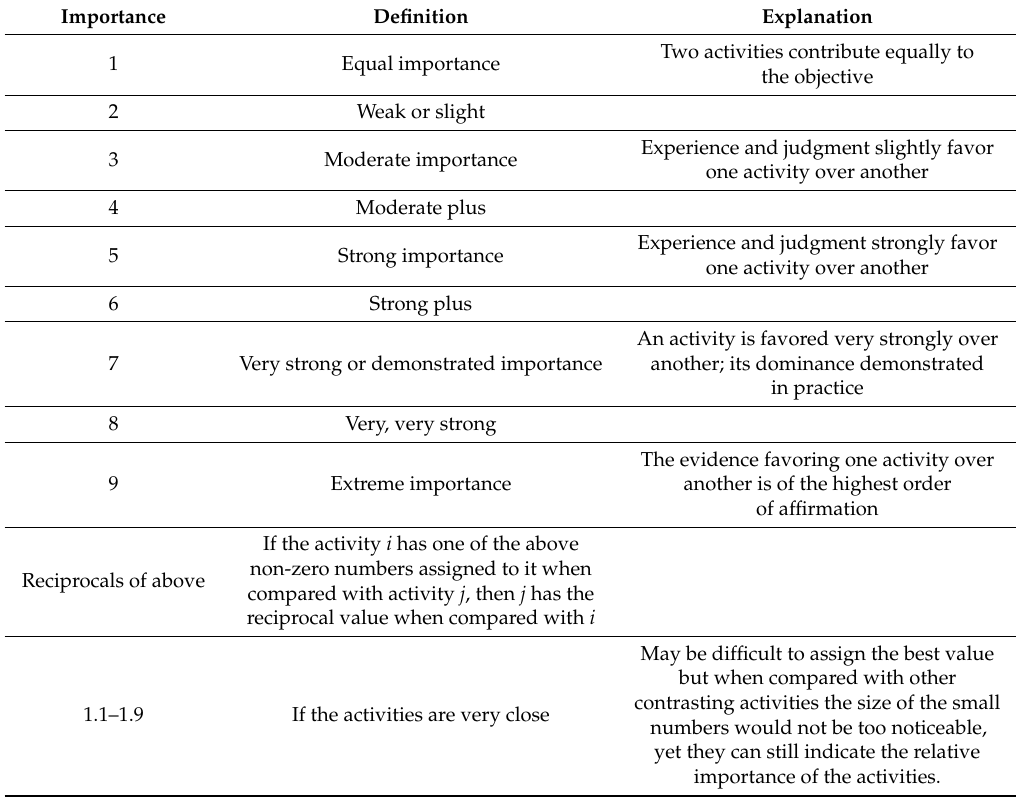
Table 2. The fundamental scale of absolute numbers, according to [29].